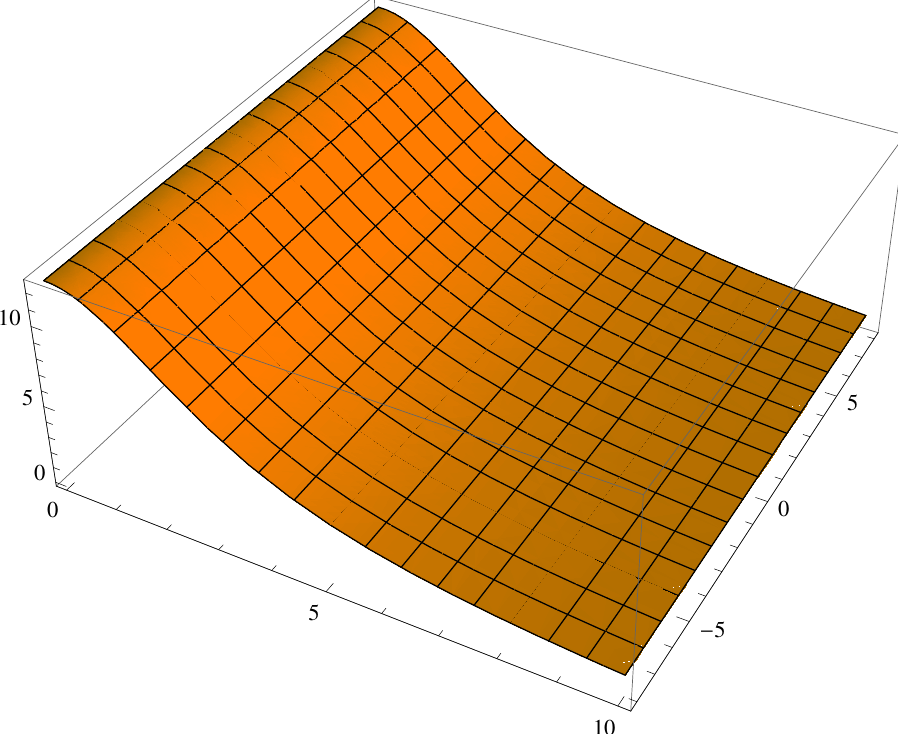
Figure 22. Variation of cosmological constant in presence of quintessence field ( ω = − 1 fluid matter ( ω = 1 ) is plotted against r with the values of the arbitrary constants λ = − 0.1, C 3 = 2, C 4 = 0.001, C 5 = 10, C 6 = 1.